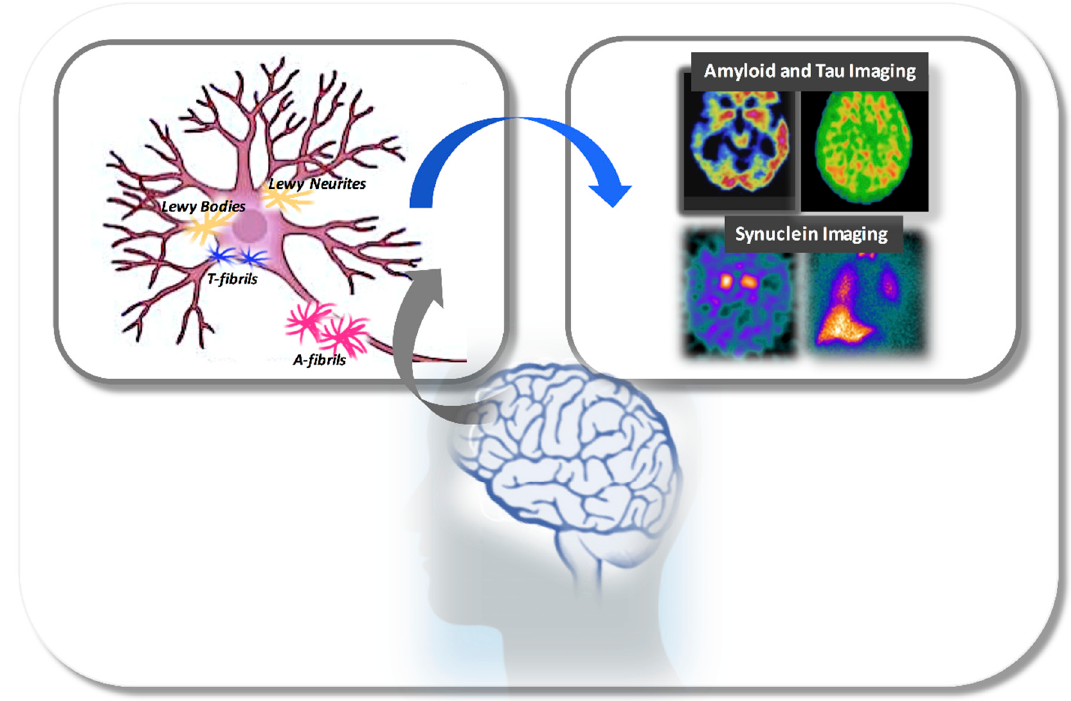
Figure 1. Schematic representation of main neuroaggregates involved in the pathological process of DLB-neurodegeneration and, main imaging tools able to detect. Abbreviations: A-fibrils, Amyloid Fibrils; T-fibrils, Tau-fibrils.